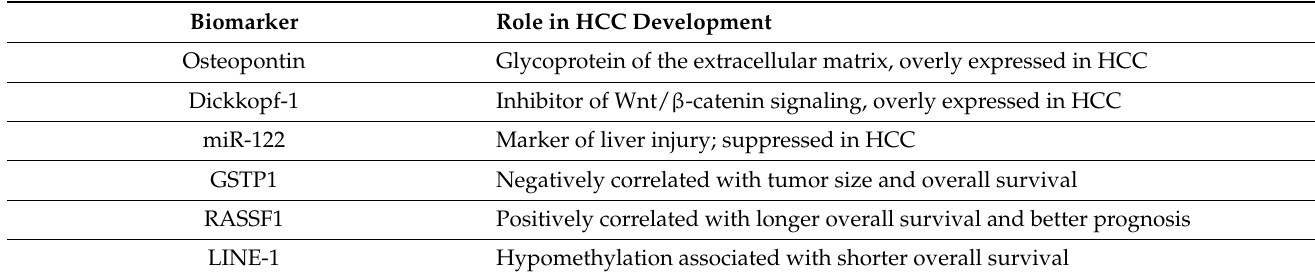
Table 2. Possible biomarkers used for the detection of hepatocellular carcinoma (HCC). Biomarker Role in HCC